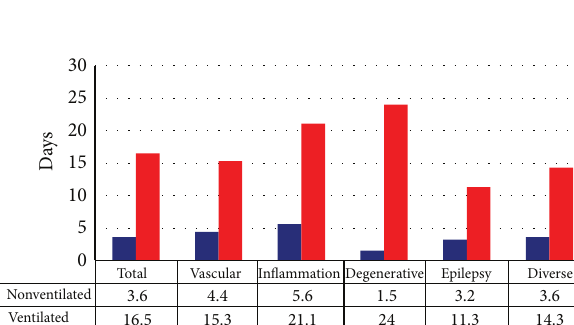
Figure 2: Length of stay